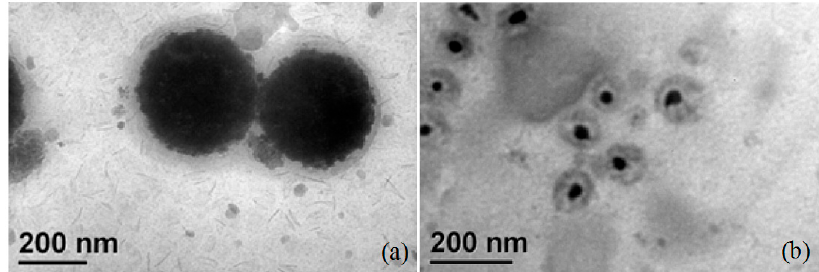
Figure 7. TEM images of micelles of P2 at 46 °C in acid medium ( a ) and basic medium ( b ).